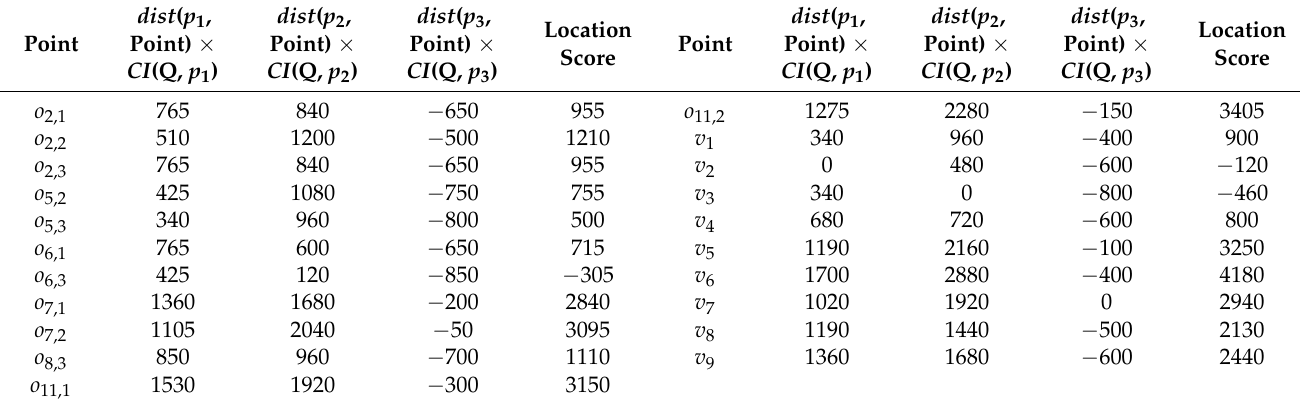
Table A4. List of location scores of vertices and break